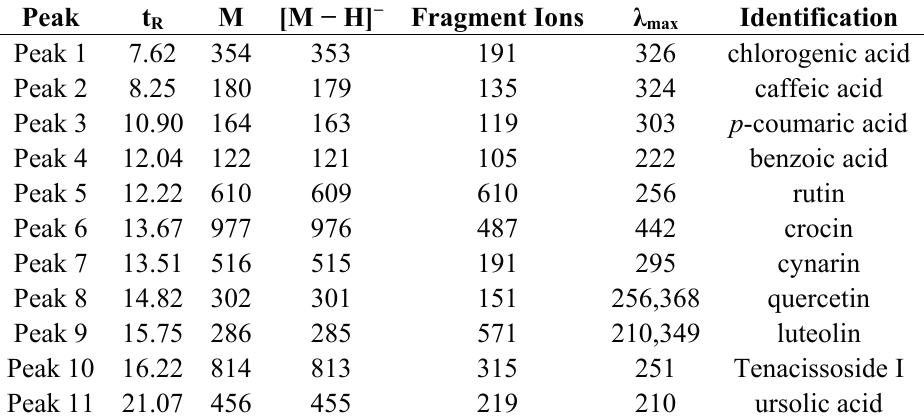
Table 1. Characterization of compounds in the fraction of burdock leaf using ultra-performance liquid chromatography (UPLC) with photo-diode array and electrospray ionization mass spectrometry